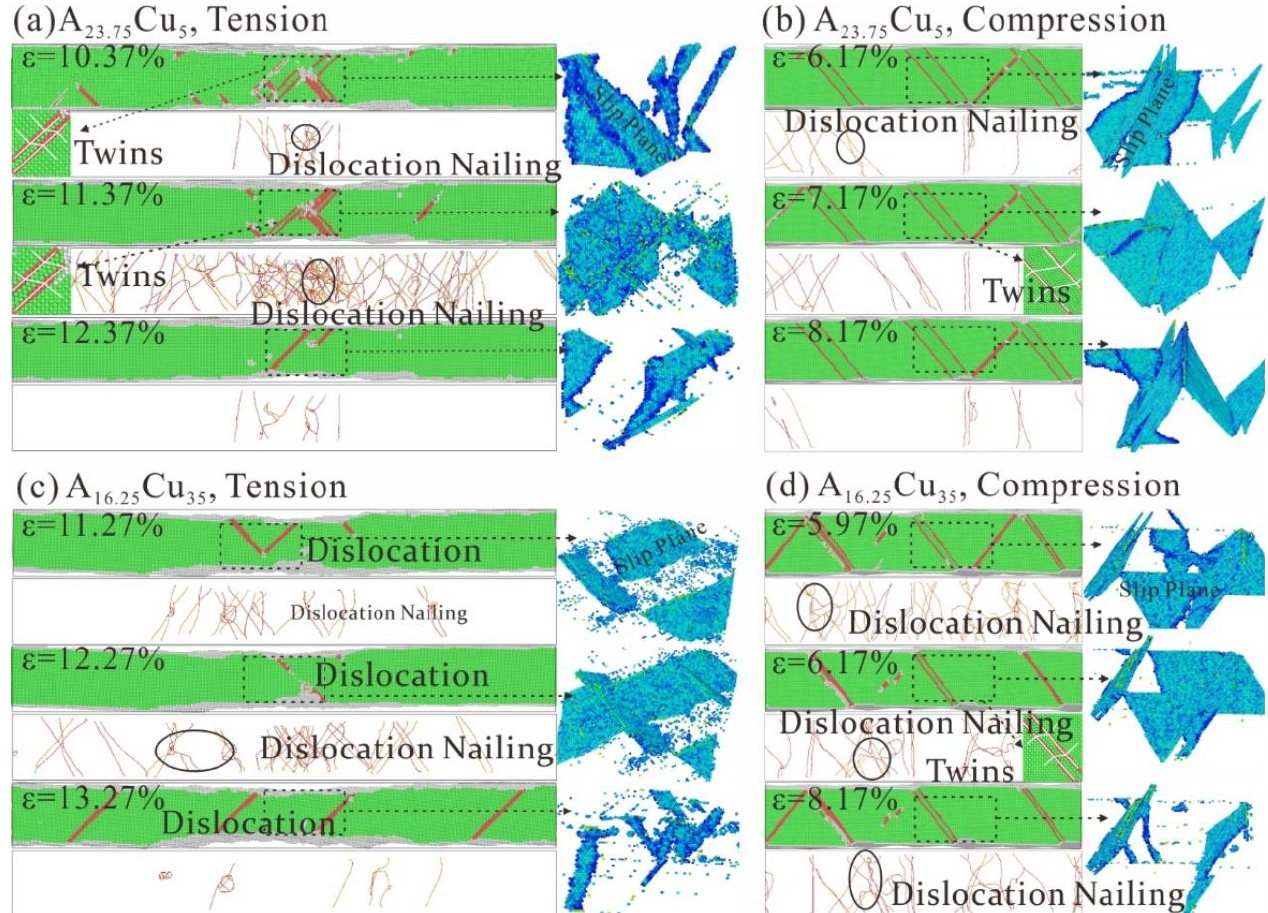
Figure 7. Microstructural evolution of FeNiCrCoCu HEAs under tensile and compression at 300 K. ( a ) CSP, DXA and CAN at tensile A x Cu 5 strains of 10.37%, 11.37% and 12.37%, respectively. ( b ) CSP, DXA and CAN at compressive A x Cu 5 at strain 6.17%, 7.17% and 8.17%, respectively. ( c ) CSP, DXA and CAN at tensile B y Cu 35 at strain 11.27%, 12.27% and 13.27%, respectively. ( d ) CSP, DXA and CAN at compressive B y Cu 35 at strain 5.97%, 6.17%, 8.17%, respectively. A x is Fe x Ni x Co x Cr x ( x = 23.75, 16.25) and B y is Ni y Co y Cr y Cu y ( y = 23.75, 16.25).